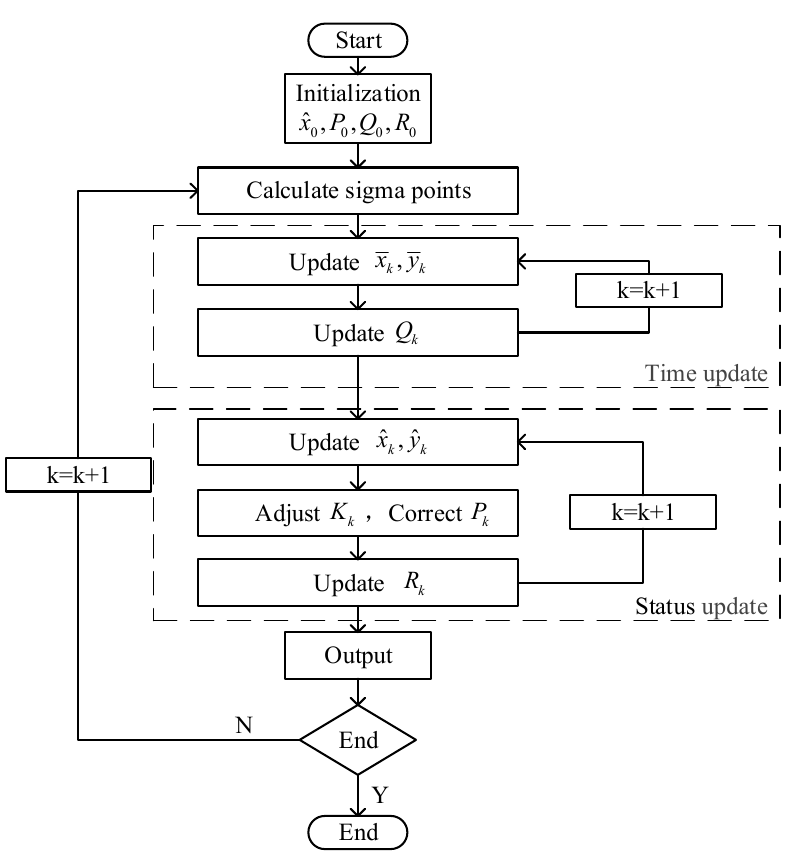
Figure 11. The flow of the AUKF algorithm.